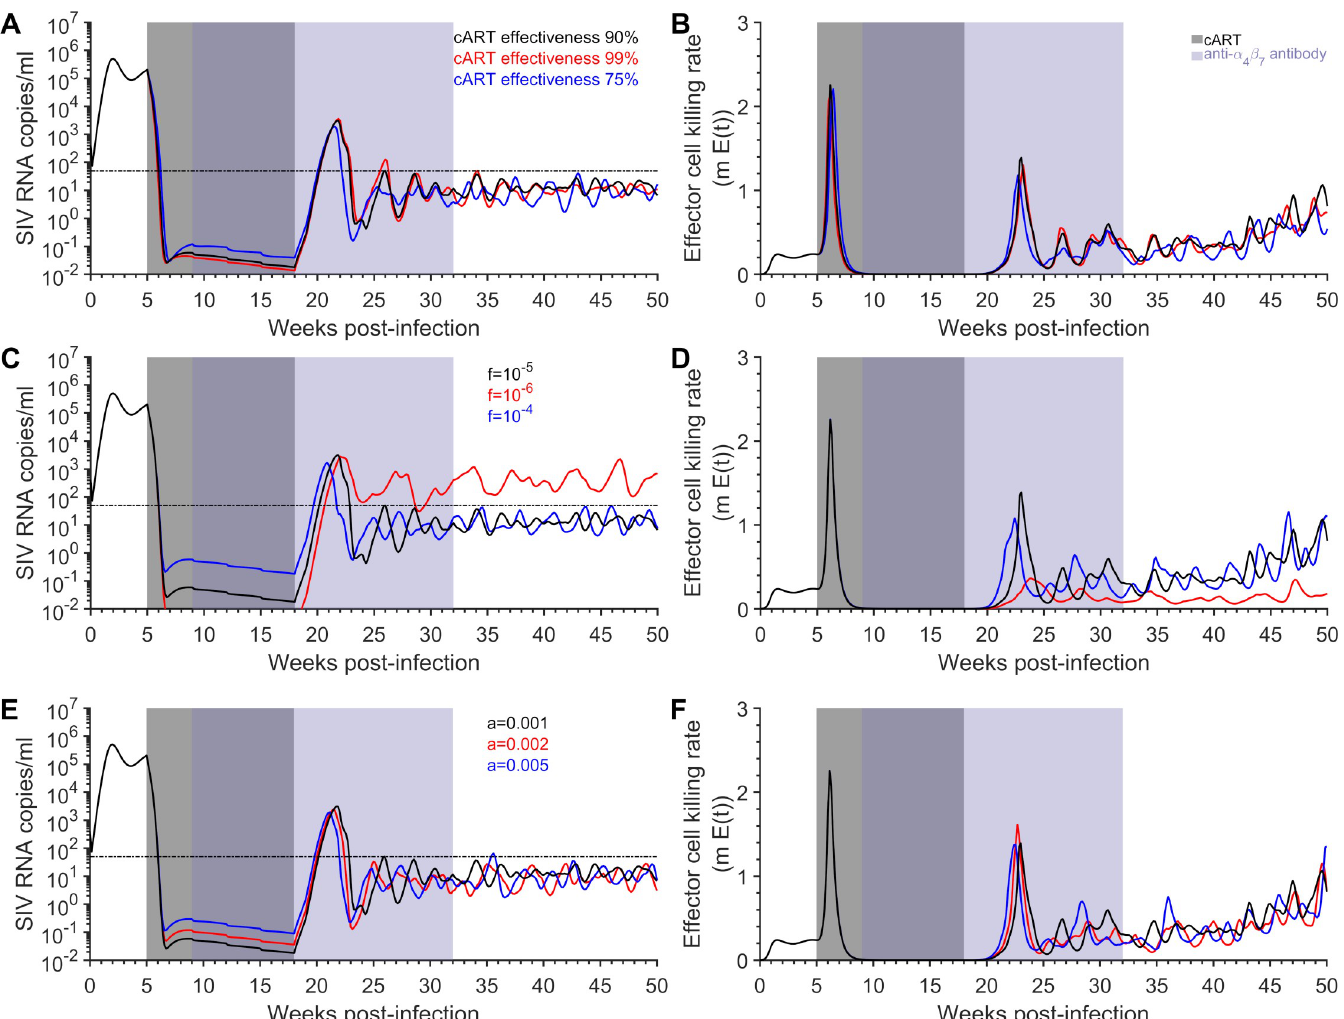
Fig 4. Sensitivity of the viral load dynamics and effector cell killing rate in the treated macaques predicted by the model. The geometric mean of the model predicted viral load (left panels) and the per day effector cell killing rate (right panels) using the best-fit parameter estimates under the baseline source model with the greatest AIC weight for each of the treated macaques. The sensitivity of the viral load and per day effector cell killing rate with respect to changing the A)-B) effectiveness of cART from 90% (black) to 99%(red) and 75% (blue), C)-D) the fraction of infections resulting in latency from 10 − 5 (black) to 10 − 6 (red) and 10 − 4 (blue), and E)-F) the activation rate of latent cells from 10 − 3 (black) to 2 × 10 − 3 (red) and 5 × 10 − 3 (blue). The limit of detection is 50 SIV RNA copies/ml (thin dashed black line, left panels). Treatment with cART occurred between 5 weeks and 18/19 weeks p.i. (gray area), while eight infusions of the anti- α 4 β 7antibody occurred between nine weeks p.i. and 32 weeks p.i. (purple area). Parameters for these simulations are in Table 1 and S14–S18 Tables, for the AIC selected mechanism (Table